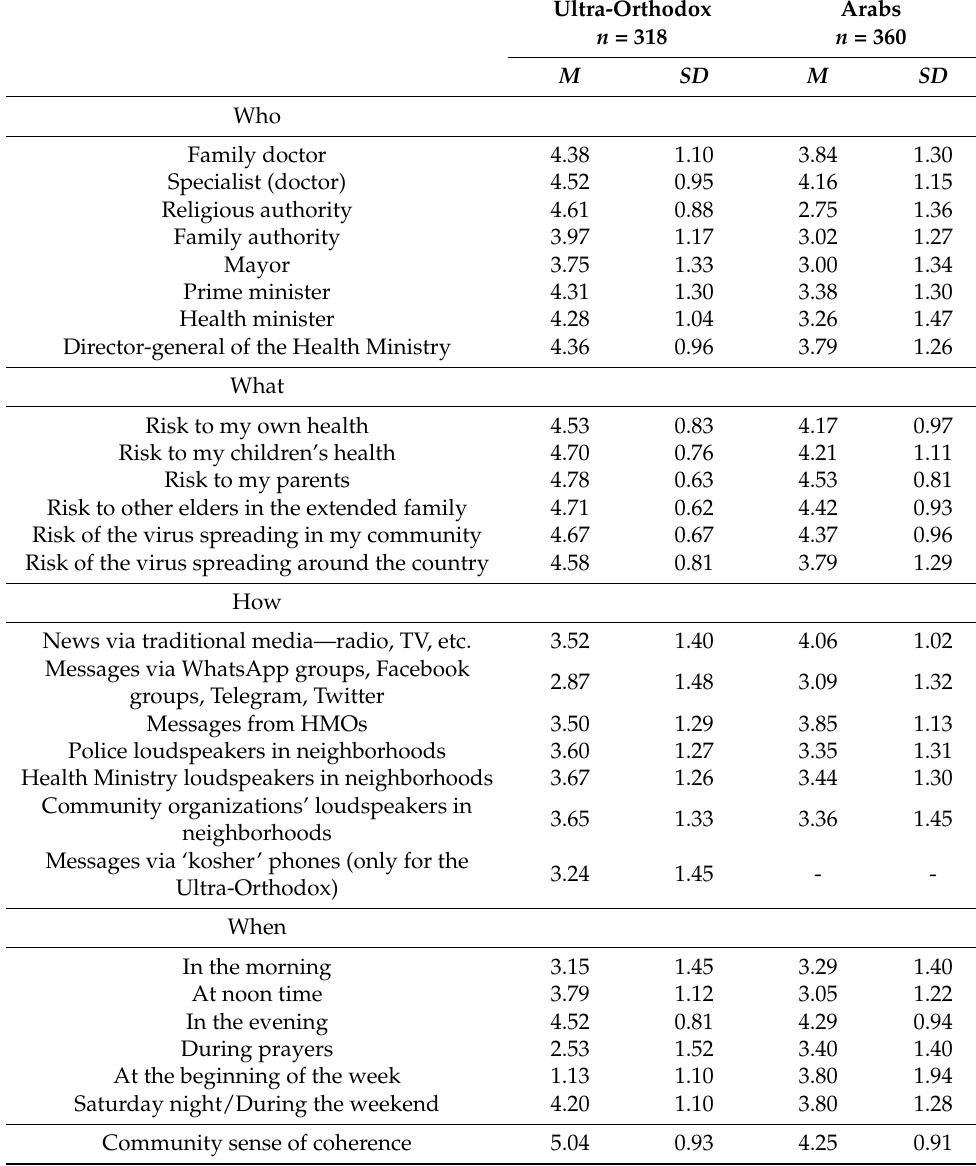
Table 1. Preferences regarding messaging among Ultra-Orthodox and Arab